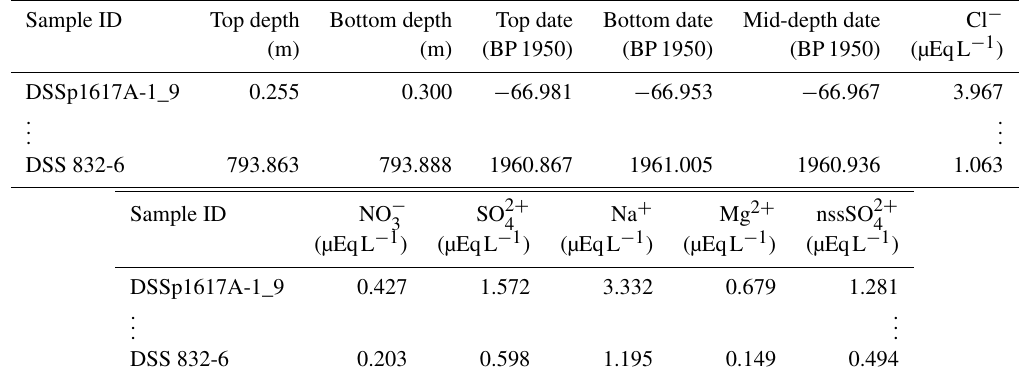
Table 5. Column headings level-1 trace ion chemistry data